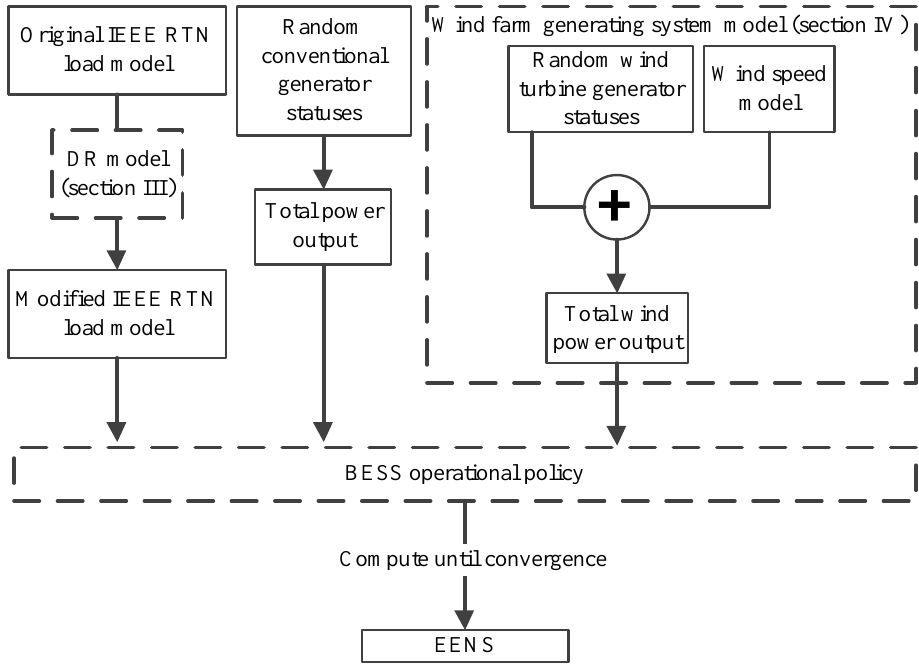
Figure 1. Overview of the simulation process.